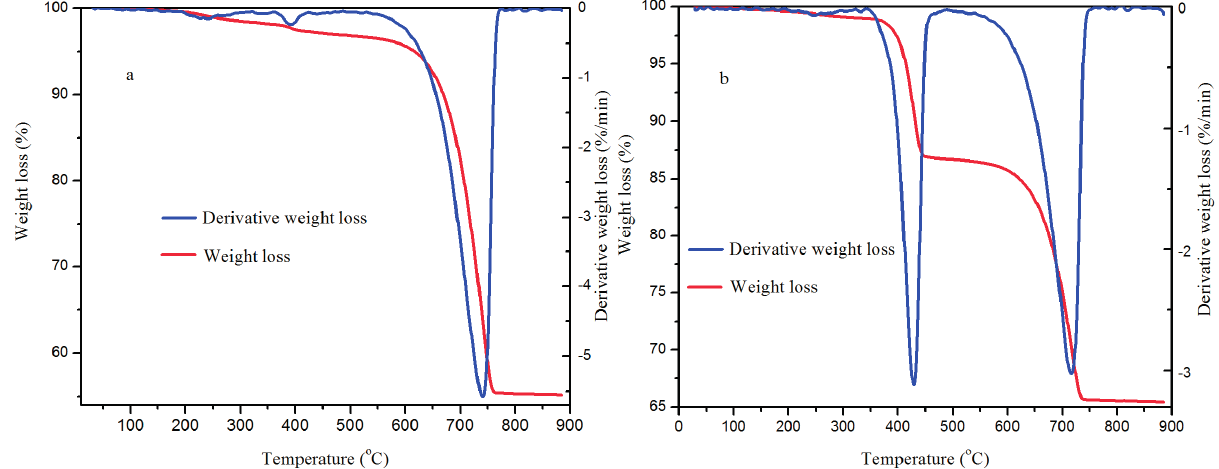
Figure 9. Thermogravimetric curves for the CaCO in 5 min at 30.0 °C.